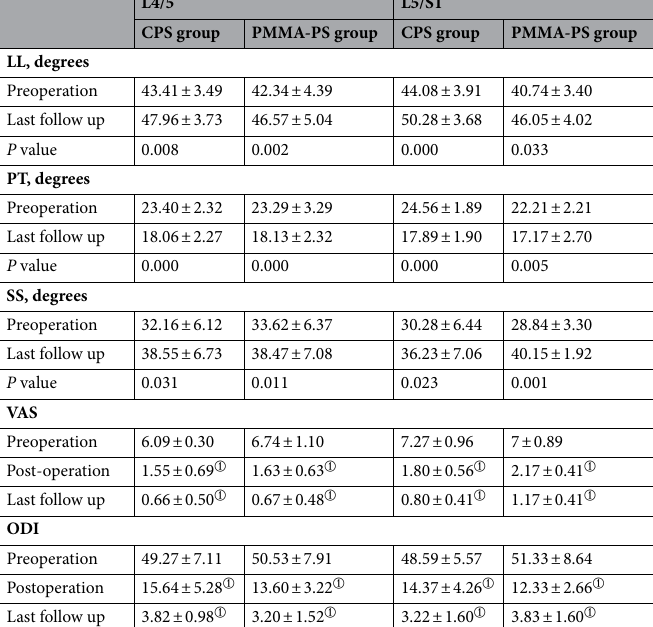
Table 3. LL, PT, SS, VAS and ODI of the two groups in the L4/5 and L5/S1 surgical segments. ① Compared with preoperation, P <